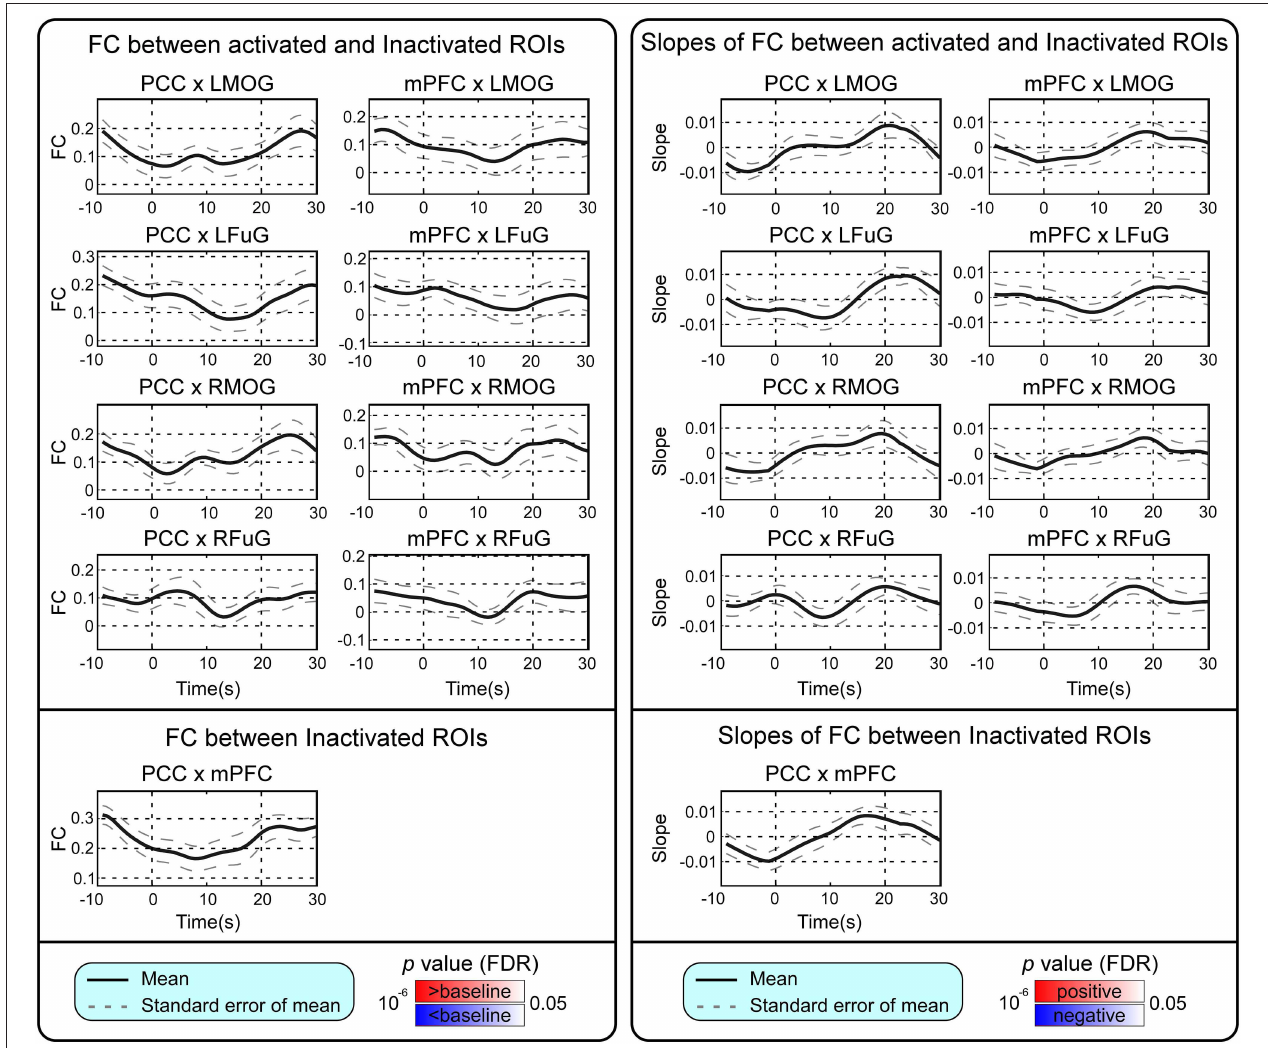
FIGURE 4 | Left: Mean and standard error of mean (SEM) of FCs between the activated ROIs and inactivated ROIs, and FC between inactivated ROIs. Two-tailed t -test was used to examine whether the FC after stimulus onset was larger or smaller than that in baseline at each time point. The time points with significantly larger or smaller ( p < 0.05 , FDR corrected) FC than that in baseline were highlighted with red or blue background, respectively. Right : Mean and SEM of slopes of FCs between activated ROIs and inactivated ROIs, and slope of FC between inactivated ROIs. Two-tailed t -test was used to examine whether the slope of FC was larger than 0 or smaller than 0 at each time point. The time points with significantly positive or negative ( p < 0.05 , FDR corrected) slope values were highlighted with red or blue background, respectively. Stimulation period was from 0 to 20s. Results were averaged across three blocks and all